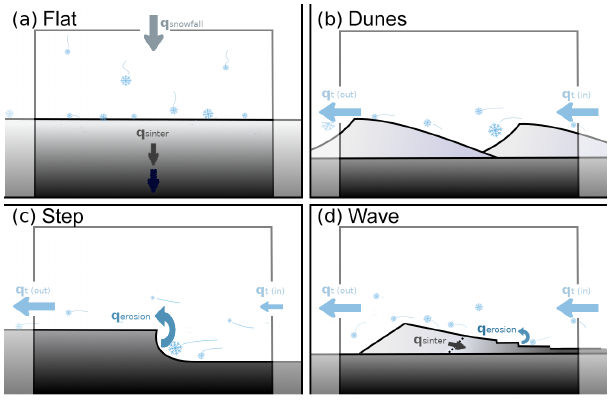
Figure 13. Expected self-organization of snow in environments dominated by (a) snowfall; (b) aeolian transport; (c) erosion, or transport on a cohesive surface; and (d) a mix of processes. Here, q refers to the total flux of snow, and q t refers to aeolian transport by creep or